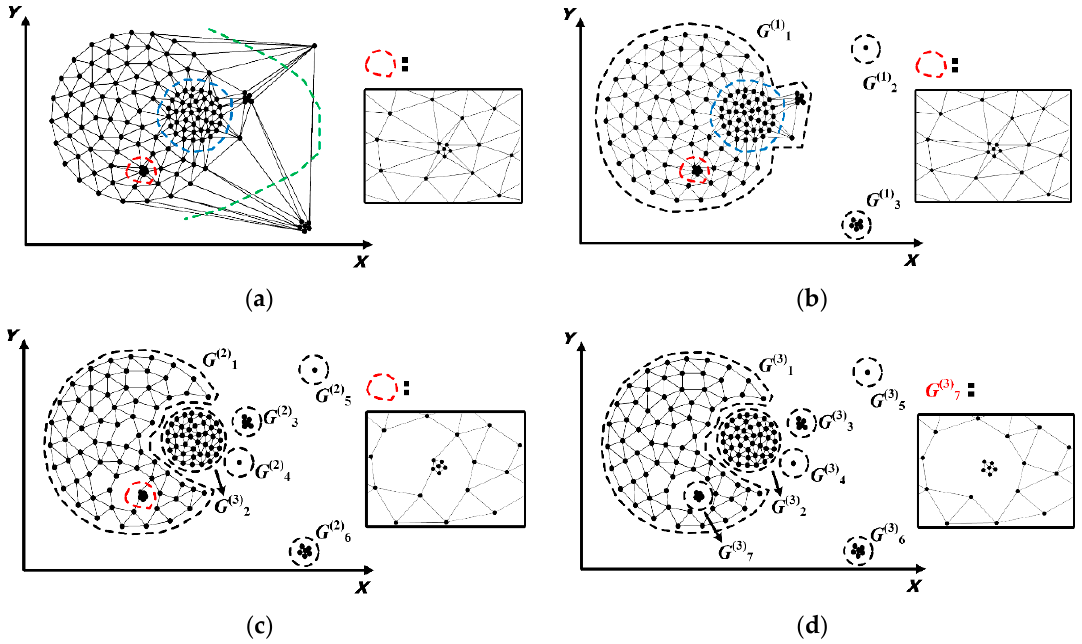
Figure 4. The process of imposing multi-constraints on Delaunay triangulation. ( a ) the initial Delaunay triangulation; ( b ) the result of imposing constraints at the macro level; ( c ) the result of imposing constraints at the middle level; ( d ) the result of imposing constraints at the micro level.